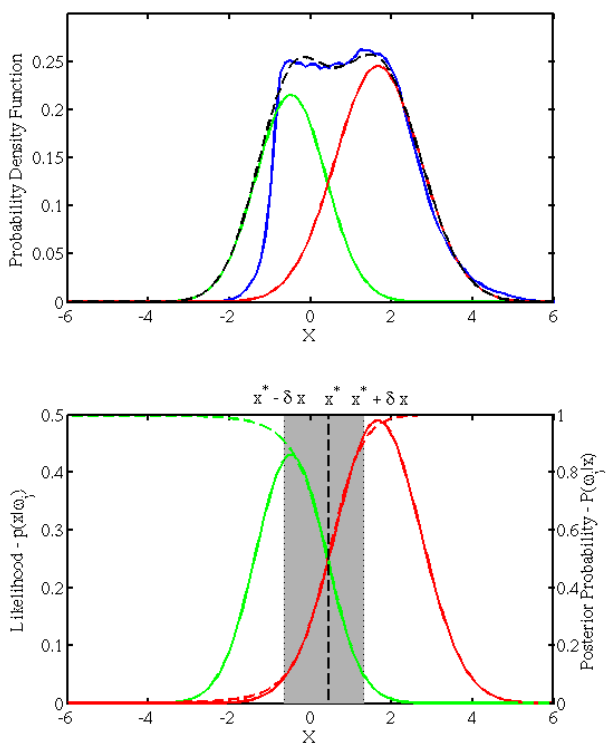
Fig. 7. Upper panel: probability density functions for October 10, 1999, over the Northern Hemisphere: probability density of f 2 /f 1 (blue curve); evidence of ω 1 (green curve); evidence of ω 2 (red curve). The black dashed curve expresses the approximation of p(x) Lower panel: the green and red solid and dashed lines are the respective likelihoods and posterior probabilities of ω 1 and ω 2 . The superimposed grey color represents the confidence interval of the boundary defined between P(ω 2 | x) ≥ 10% and P(ω 1 | x) ≥